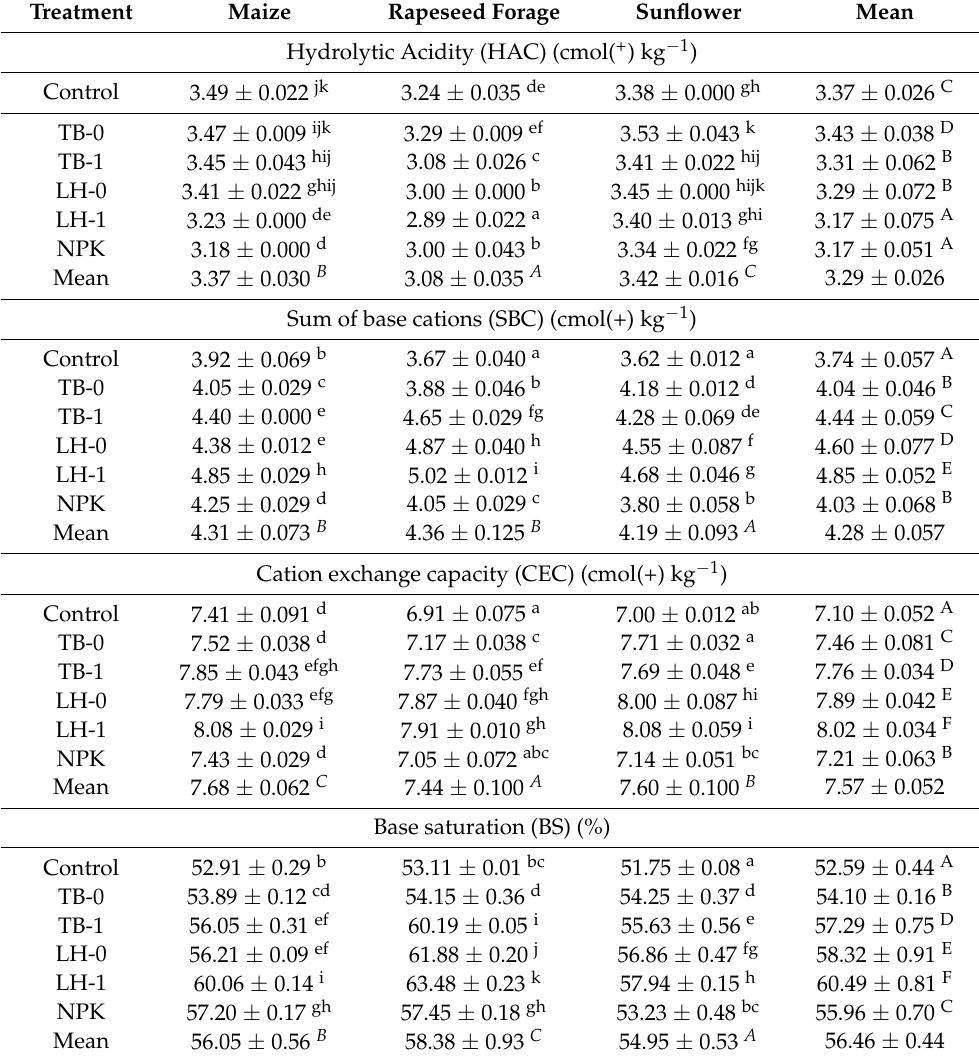
Table 4. The effect of PM application on the properties of the soil sorption complex after the first year of plant